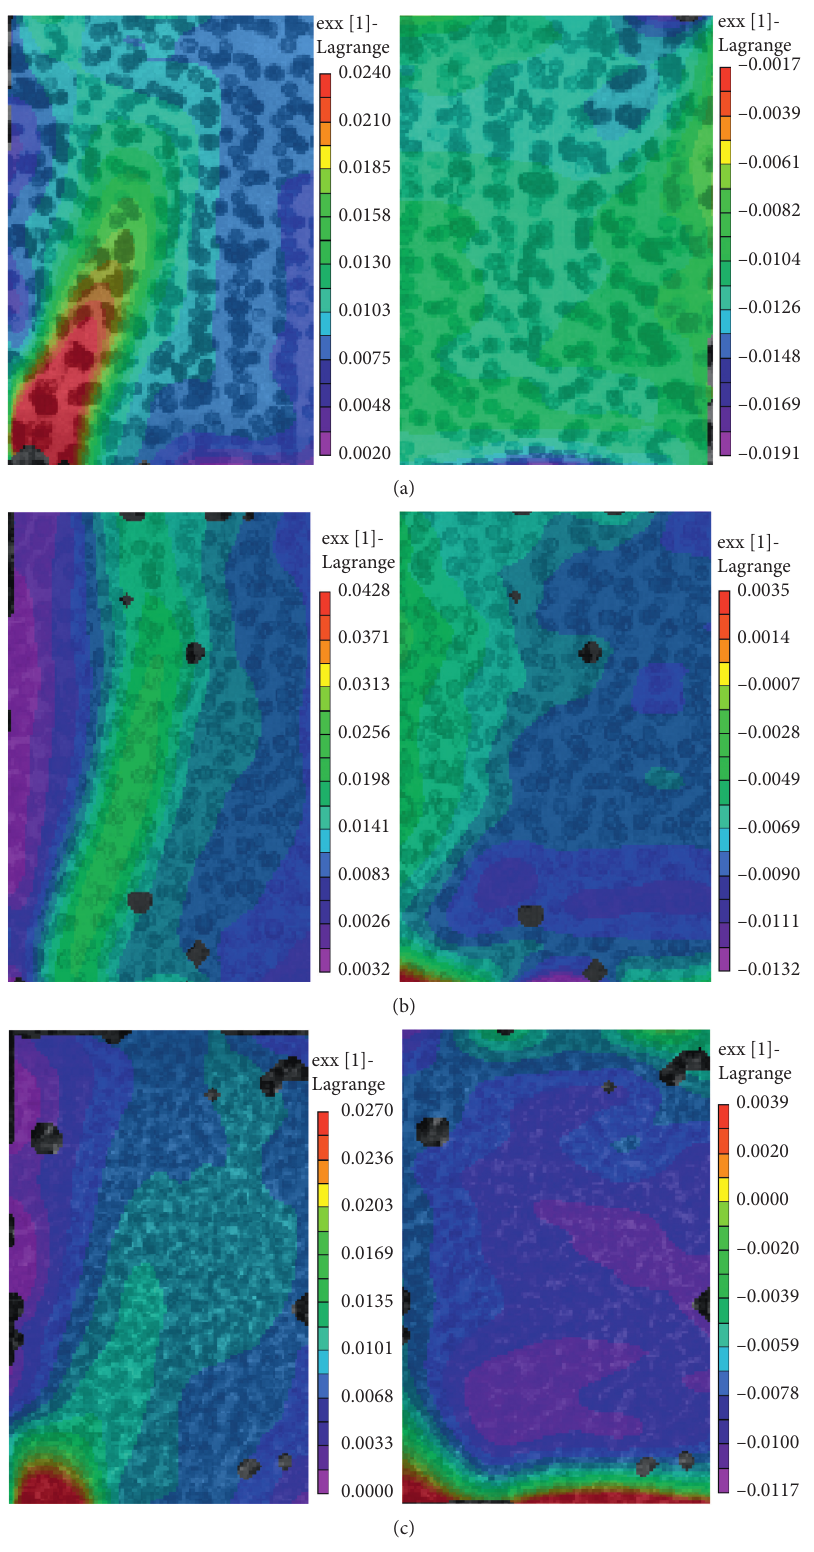
Figure 10: Imaging results when DIC processes critical damage (positive as tensile strain, negative as compressive strain). (a) S8090110-3 critical strain DIC map (unit: cm): (left) X -direction displacement field and (right) Y -direction displacement field. (b) S8090110-4 critical strain DIC map (unit: cm): (left) X -direction displacement field and (right) Y -direction displacement field. (c) S8090110-5 critical strain DIC map (unit: cm): (left) X -direction displacement field and (right) Y -direction displacement